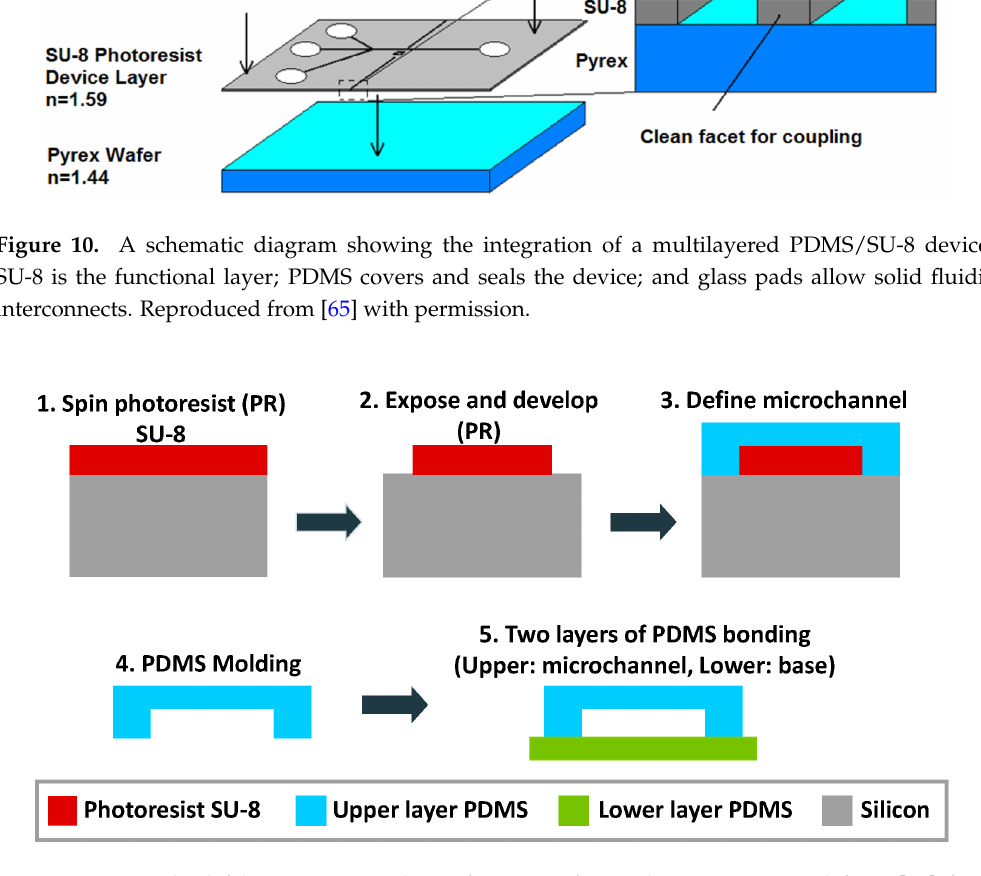
Figure 11. Standard fabrication procedure of a PDMS/SU-8 device. Reprinted from [81] from Micromachines published by